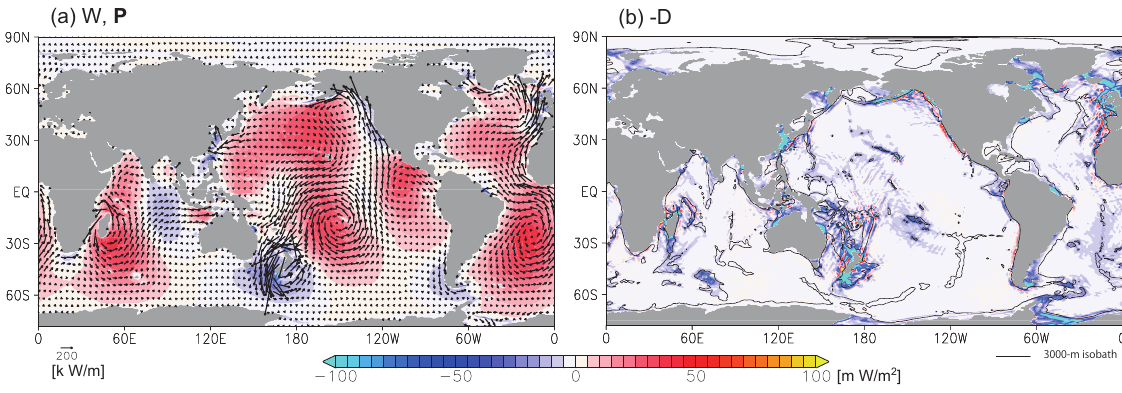
Fig. 8. (a) Tidal energy flux P (vector) and power on the ocean W [ 10 − 3 W m − 2 ] (color shades) in case M2. The unit length of the vectors is 200 k W m − 1 the same as Fig. 1 of Egbert and Ray (2001). (b) Tidal energy dissipation − D in case M2. The 3000-m isobath is shown to illustrate the bottom topography.